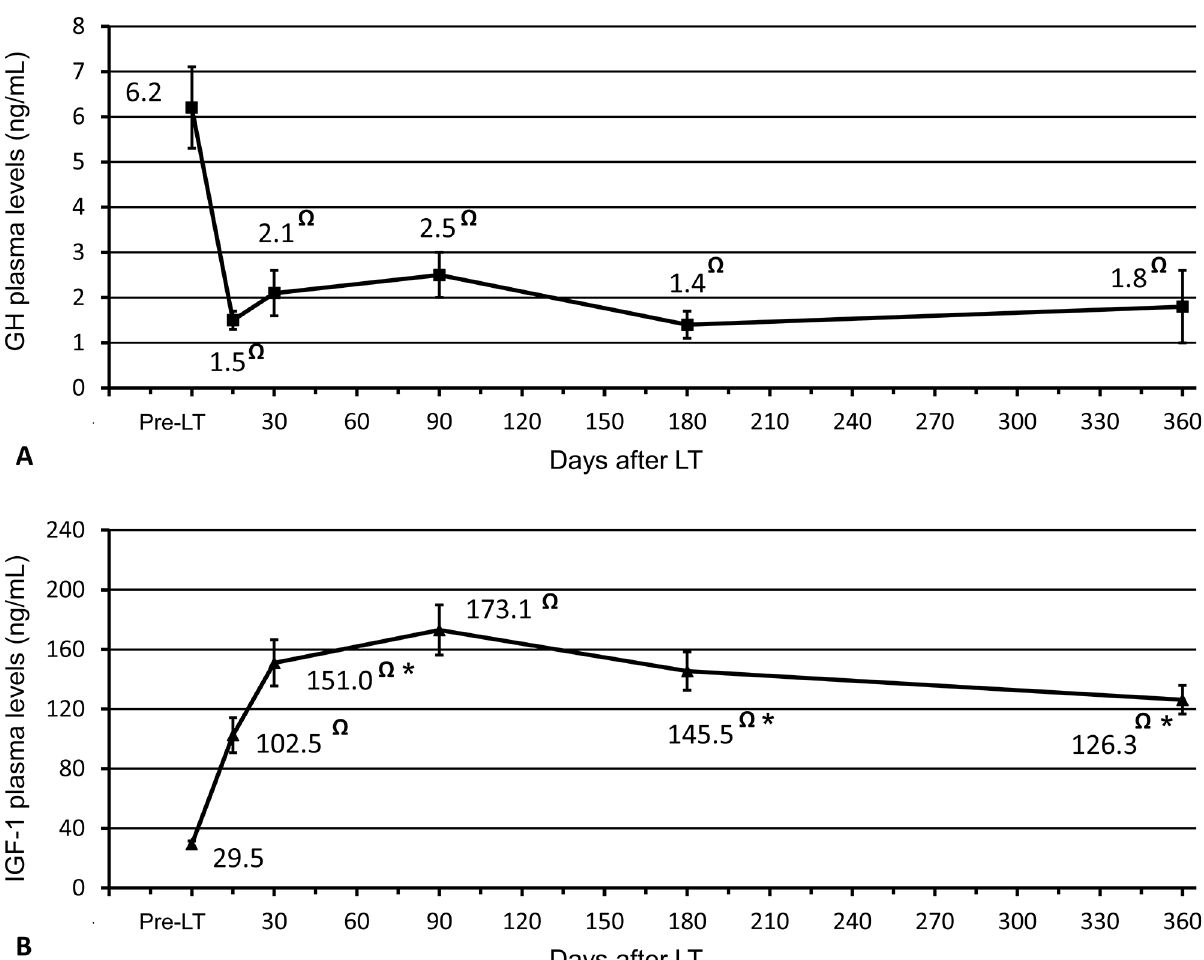
Fig 1. (A) Serum levels of growth hormone (GH) and (B) insulin-like growth factor 1 (IGF-1) before and after liver transplantation. Values are expressed as the mean ± standard error of the mean. Student ’ s t test for paired samples was employed to investigate significant differences in hormonal values over time. * p < 0.05 compared with the previous value; Ω p < 0.01 compared with the pre-LT value. Abbreviations: IGF-1, insulin-like growth factor 1; LT, liver transplantation; GH, growth